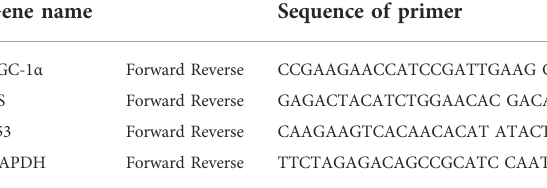
TABLE 2 The primers sequence used in real-time